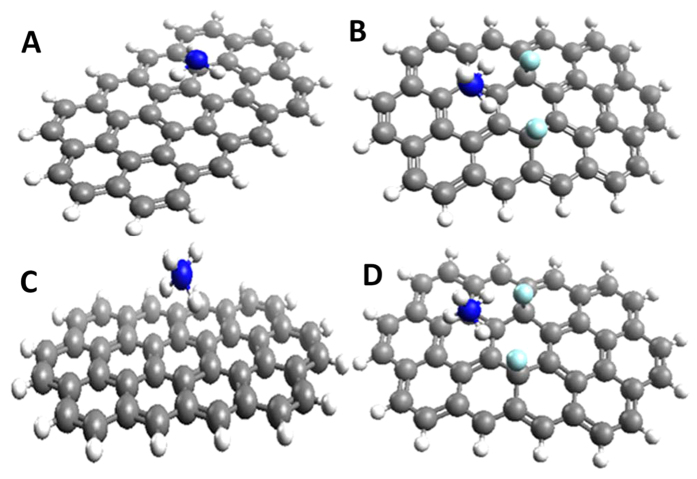
Optimized graphene/FG and ammonia/ammonium structures: (A) graphene-ammonia (C39H16-NH3), (B) FG -ammonia (C39H16F2-NH3), (C) graphene-ammonium (C39H16-NH4+), and (D) FG– ammonium (C39H16F2-NH4+).